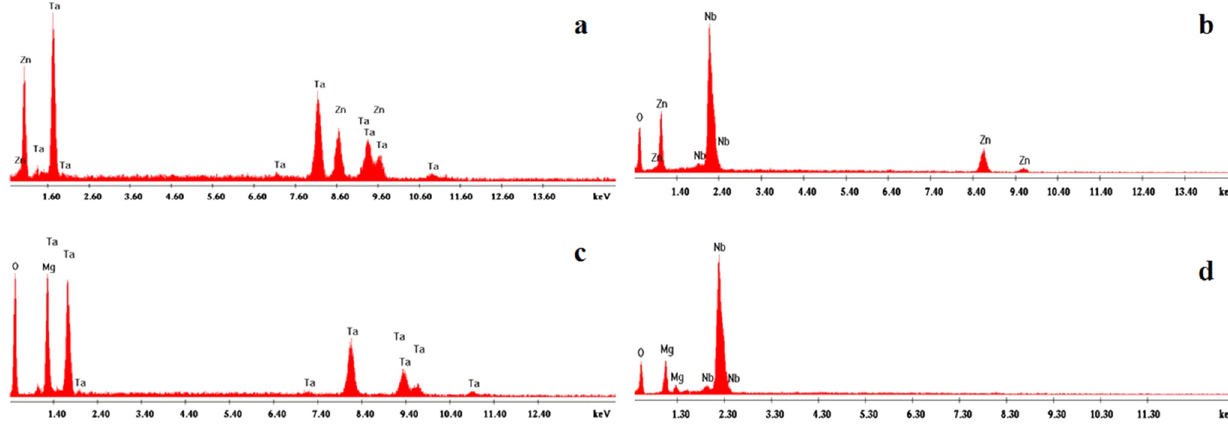
Fig. 3. The EDAX images for (a) ZnTa 2 O 6 , (b) ZnNb 2 O 6 , (c) MgTa 2 O 6 and (d) MgNb 2 O 6 nanomaterials.